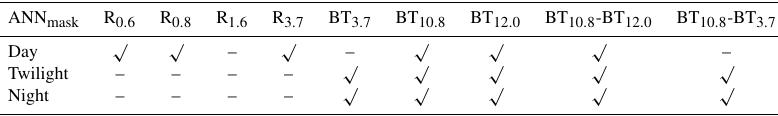
Table B1. Measurement input to the trained artificial neural network for cloud detection (ANN mask ), used for different illumination con- ditions: daytime, twilight and night-time. The subscript in the table’s headline corresponds to the approximate central wavelengths of the channels: 0.6, 0.8, 1.6, 3.7, 10.8 and 12.0µm. In addition to the measurement input, all ANNs require surface temperature, a snow–ice flag and a land–sea flag as input. R is reflectance, and BT is brightness temperature.